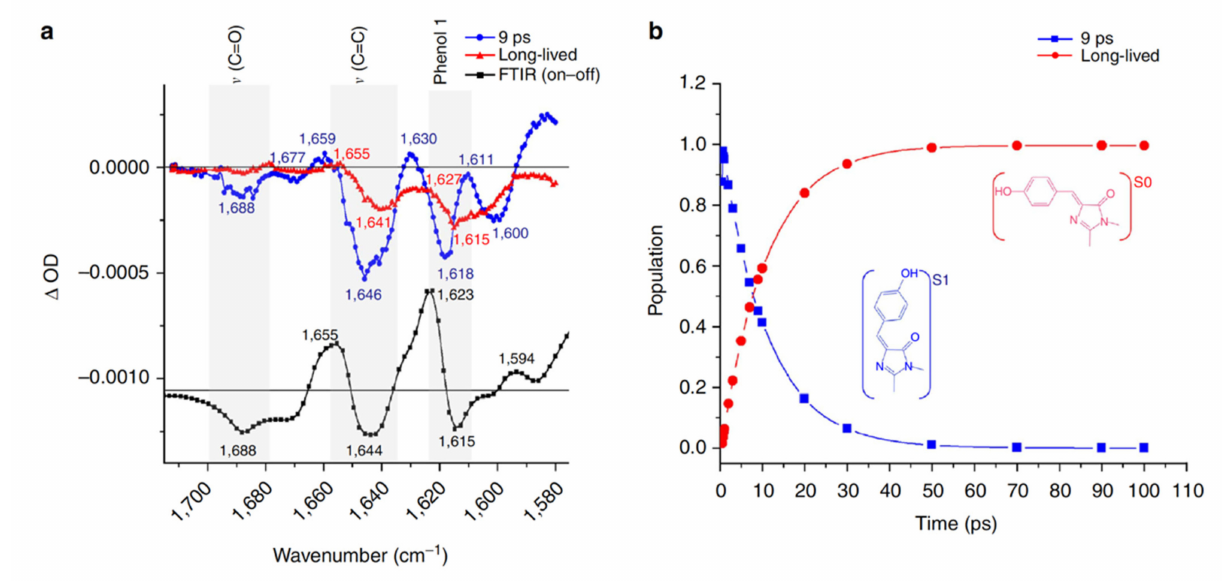
Figure 2. Time-resolved infrared (IR) spectroscopy reveals characteristic species during the off-to-on photoswitching of Dronpa after 400 nm excitation. ( a ) Time-resolved difference spectra (pump-on minus pump-off) retrieved from global analysis with a sequential model (blue → red) and the FTIR difference spectra between the on and off states in D 2 O (black). ( b ) Global fitting results of the short-lived (blue) and long-lived (red) species with a dominant 9 ps component due to the decay of the singlet excited state of the trans -neutral chromophore (blue structure shown in the inset). Reprinted with permission from Ref. [55]. Copyright 2013 The